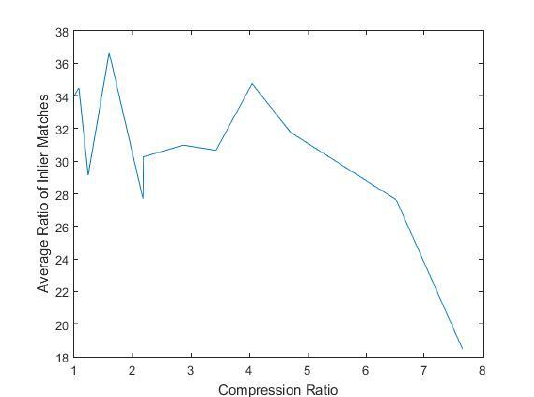
Figure 13. Average ratio of inlier matches of the original and compressed image sets The accuracy of the exterior orientations of the original and compressed image sets estimated by fully automatic POS- supported aerial triangulation is given by Table 4. It can be seen that the orientation accuracies of the losslessly and lossily compressed images are comparable to that of the original images. Table 4. Accuracy of the exterior orientations of the original and compressed image sets